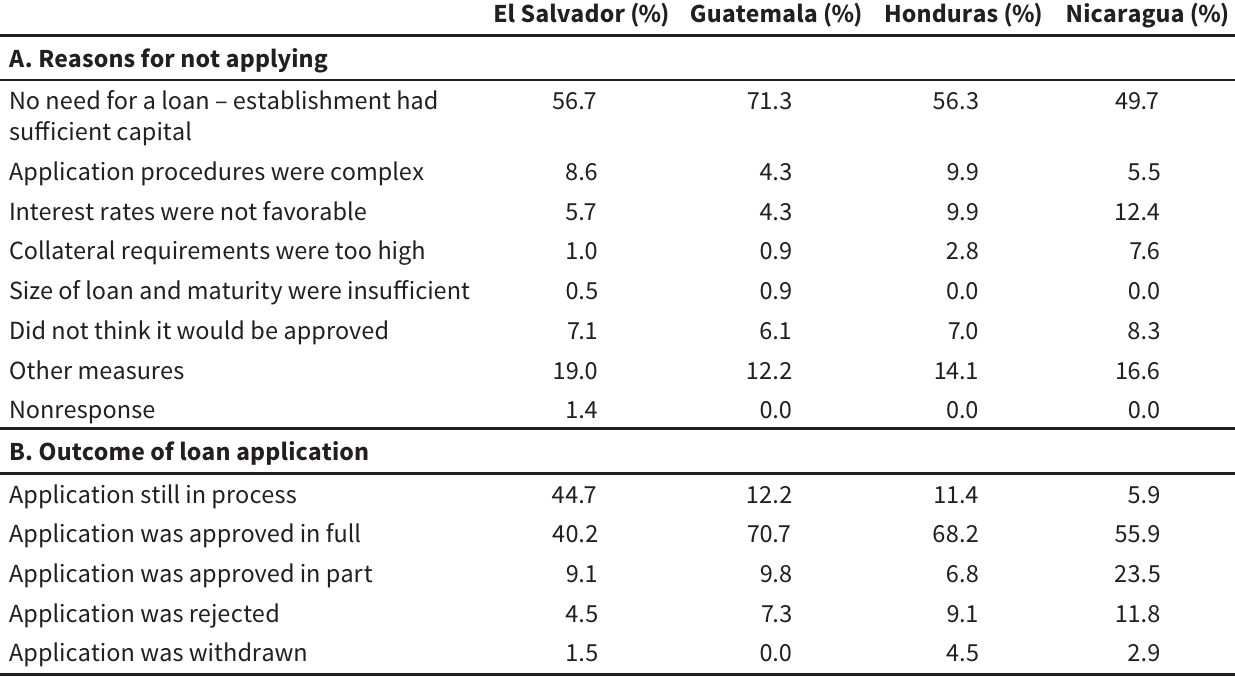
Main reason for not applying for a loan and the outcomes of loan applications (% of firms by country) El Salvador (%) Guatemala (%) Honduras (%) Nicaragua